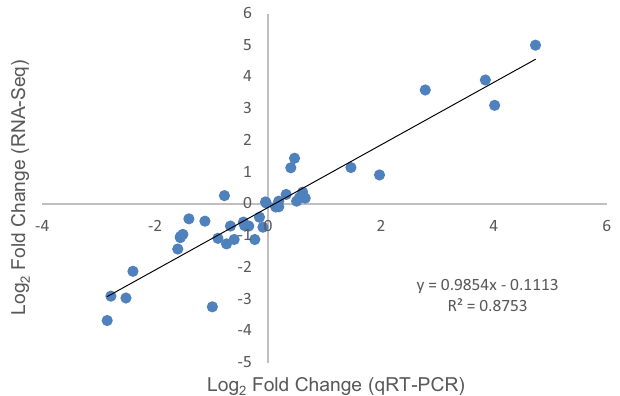
Figure 6. Correlation of expression patterns of selected genes from RNA-Seq and